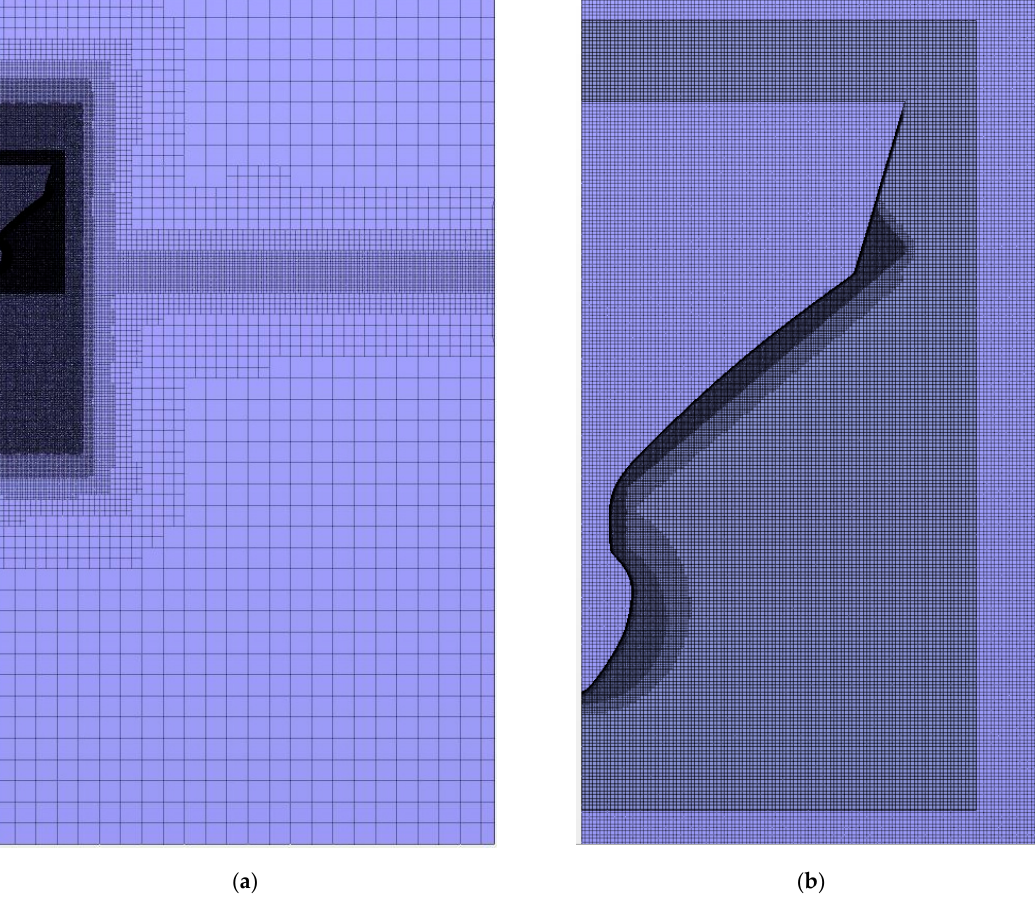
Figure 2. Mesh domain: ( a ) global domain; ( b ) view of grid structures.